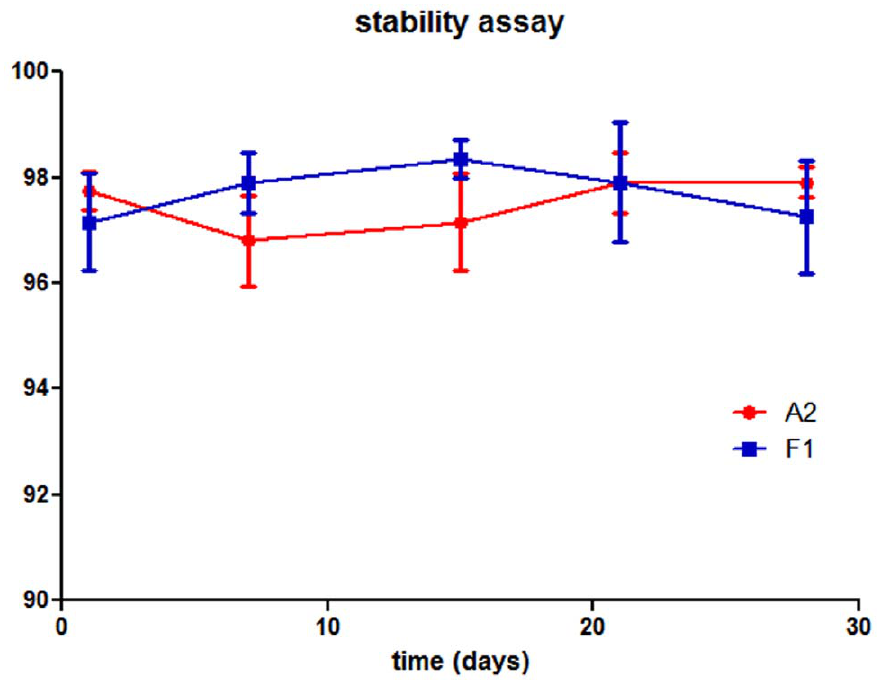
Figure 8. Stability test of yeast expressed scFv-Fc fusions. Unpurified scFv-Fc fusions were tested for binding to Ag85 by ELISA (Ag85 was adsorbed to plastic) at regular periods over 4 weeks. Results are expressed as percent signals obtained on the first day.